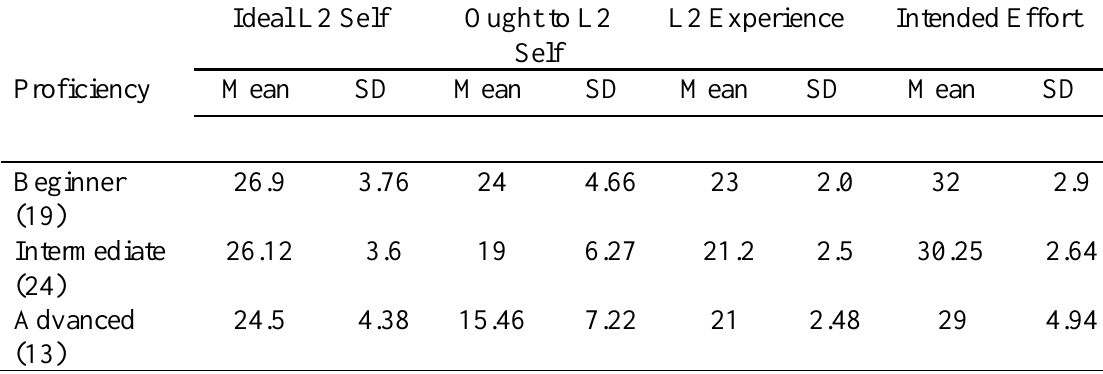
Descriptive Statistics for Motivation Composites (N =